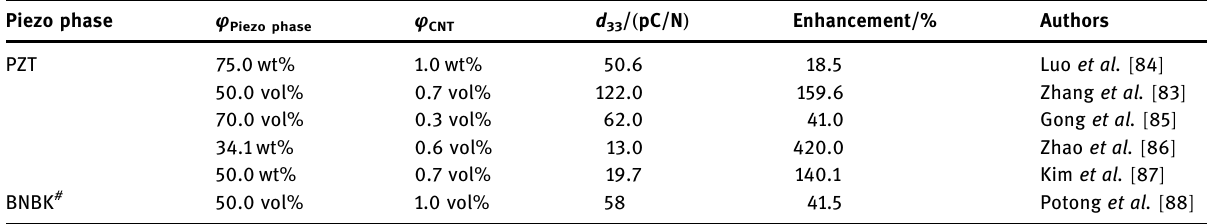
Table 1: Piezoelectric properties of CNT enhanced PCM Piezo